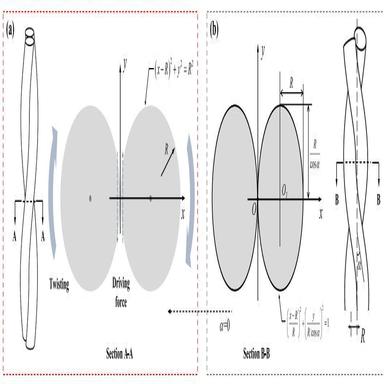
(a) Schematic diagram of the circular cross-section model; (b) Geometric relationships and schematic diagram of the main parameters of the elliptical crosssection model;